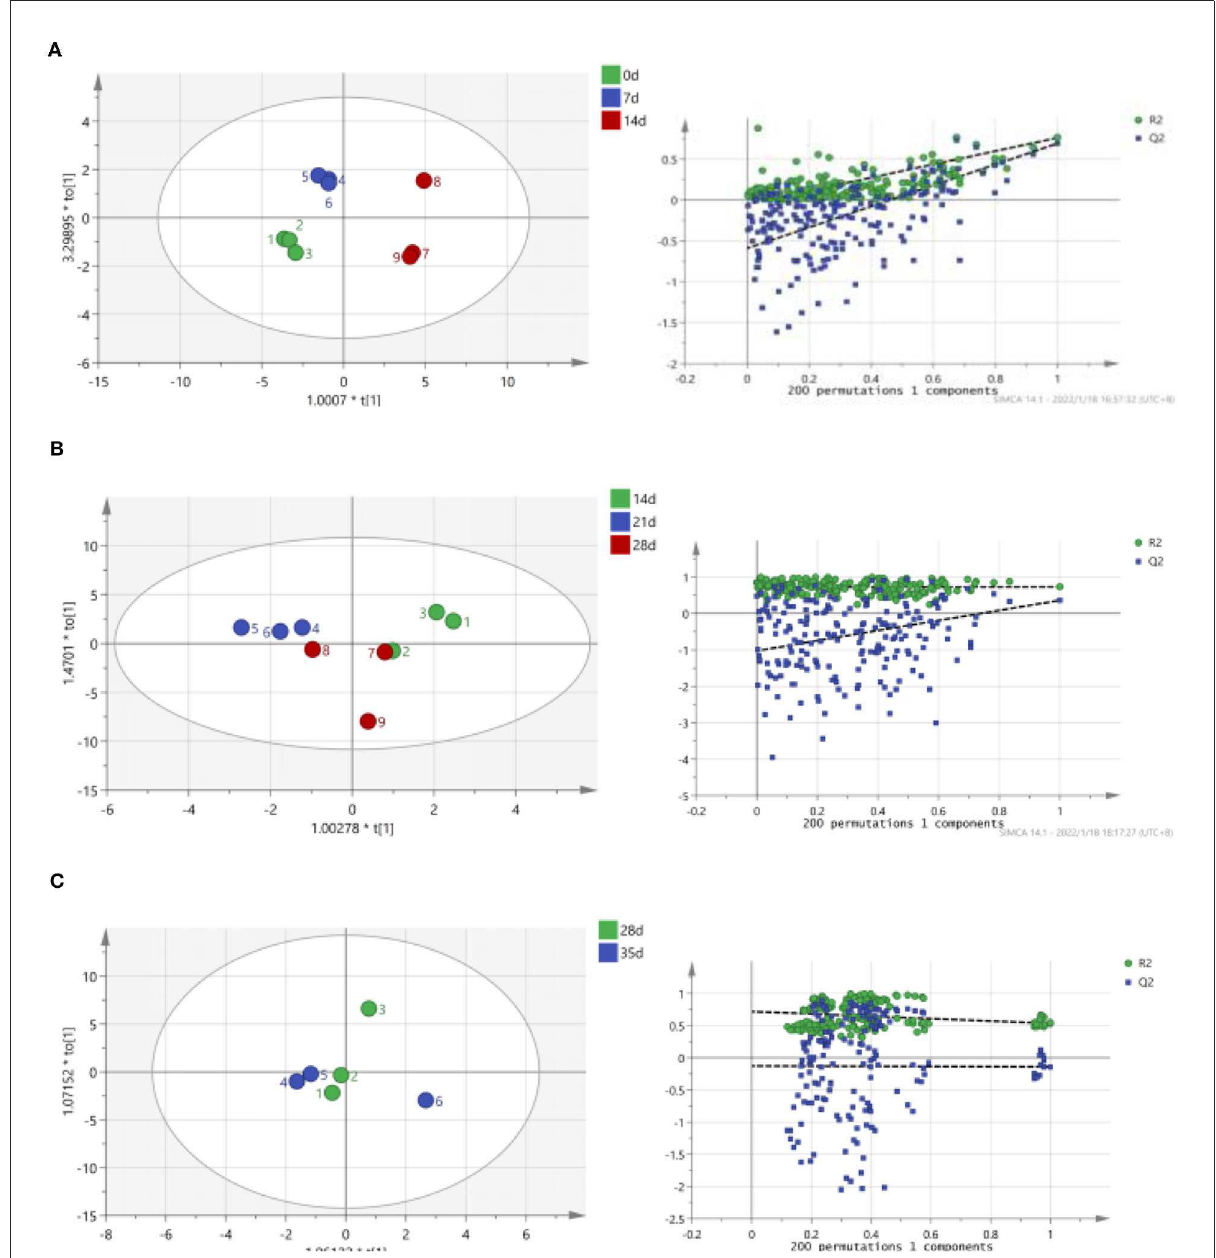
FIGURE4 Correlation between endogenous protease activity, TCA soluble peptide and free amino acid contents in preserved egg yolk at different pickling stages (OPLS score chart and replacement test chart of preserved egg yolk at different pickling stages). (A) : 0–14d; (B) : 14–28d; (C) : 28–35d.